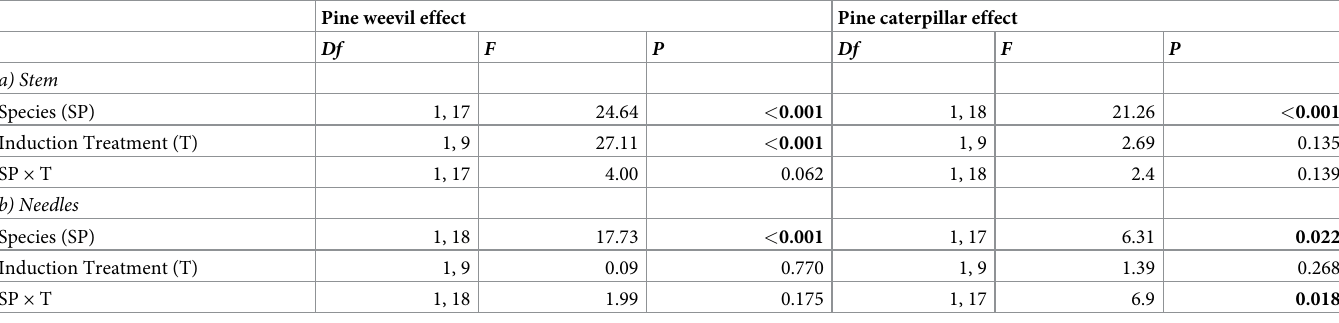
Table 1. Effects of the herbivore-induction treatments on the concentration of total resin acids in the stem (a) and in the needles (b) tissues of two pine